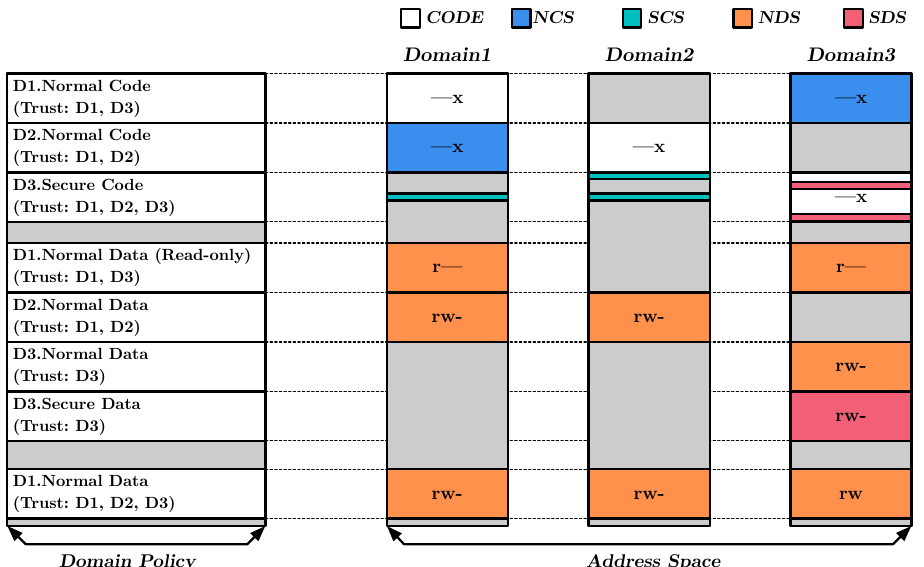
Figure 3. Memory protection functionality in DEMIX